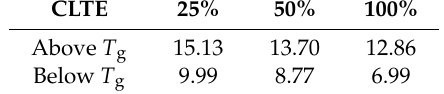
Table 1. Coefficients of linear thermal expansion under different cross-linking densities, in unit 10 − 5 K − 1 . CLTE 25% 50% 100% Above T g 15.13 13.70 12.86 Below T g 9.99 8.77 6.99